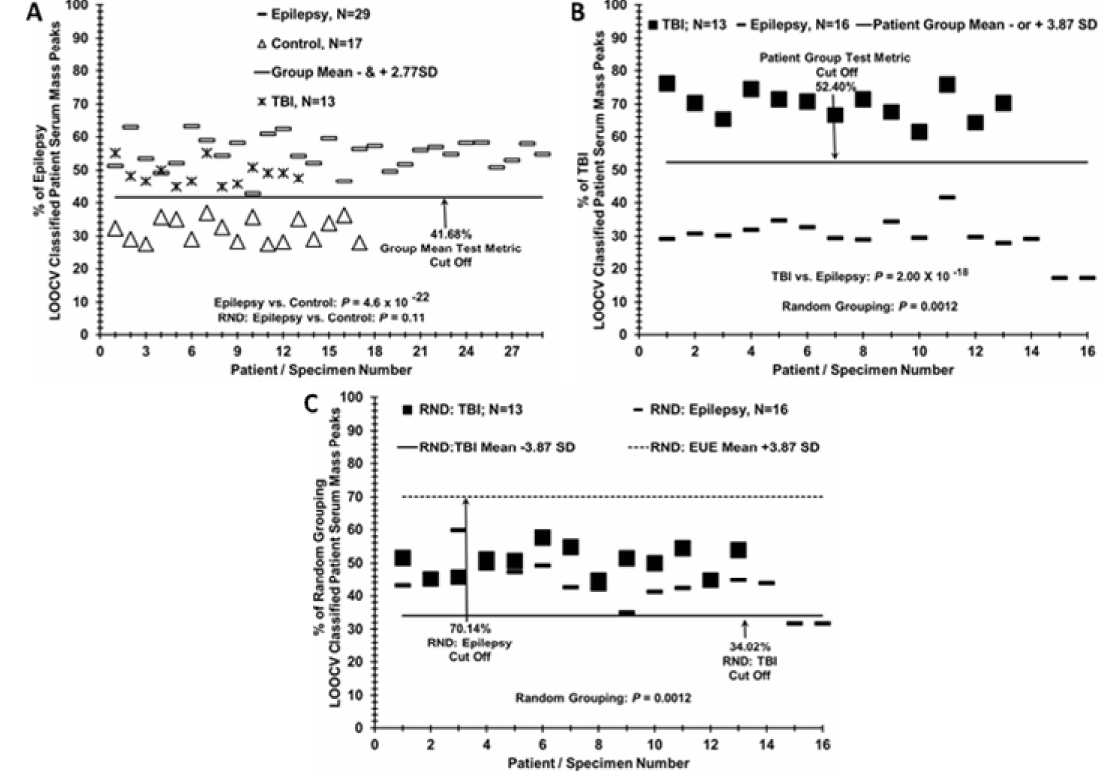
Figure 3. Sera from TBI patients are more closely related to Epilepsy patients when compared to controls. ( A ) Segregation of TBI patient sera (Xs) with epilepsy sera (dashes) when both are LOOCV/PCV compared to control individual sera (triangles). ( B ) Distinguishing TBI patient sera from epilepsy patient sera when compared to each other directly by the LOOCV analysis. ( C ) Random LOOCV grouping of sera from epilepsy patients and TBI patients from panel B; demonstration of lack of group separation ( p value 0.0012).